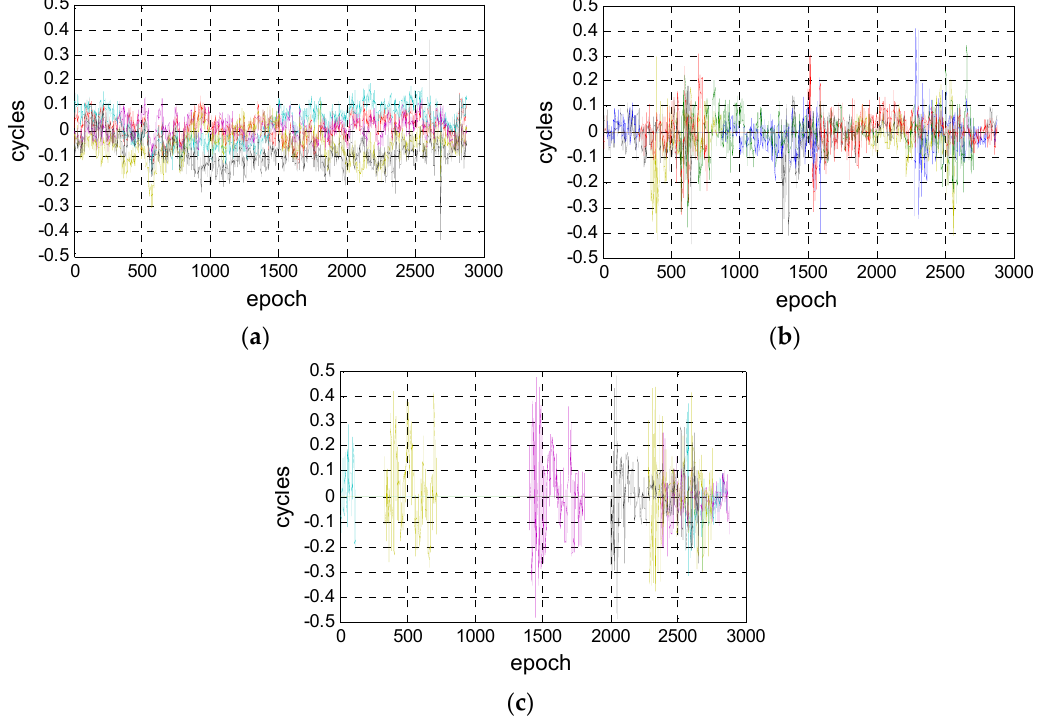
Figure 3. Variation of distribution of the difference (DF) of three kinds of BDS satellites. GEO = Geostationary Earth Orbit; IGSO = Inclined Geosynchronous Satellite Orbit; MEO = Medium Earth Orbit. ( a ) GEO; ( b ) IGSO; ( c ) MEO.